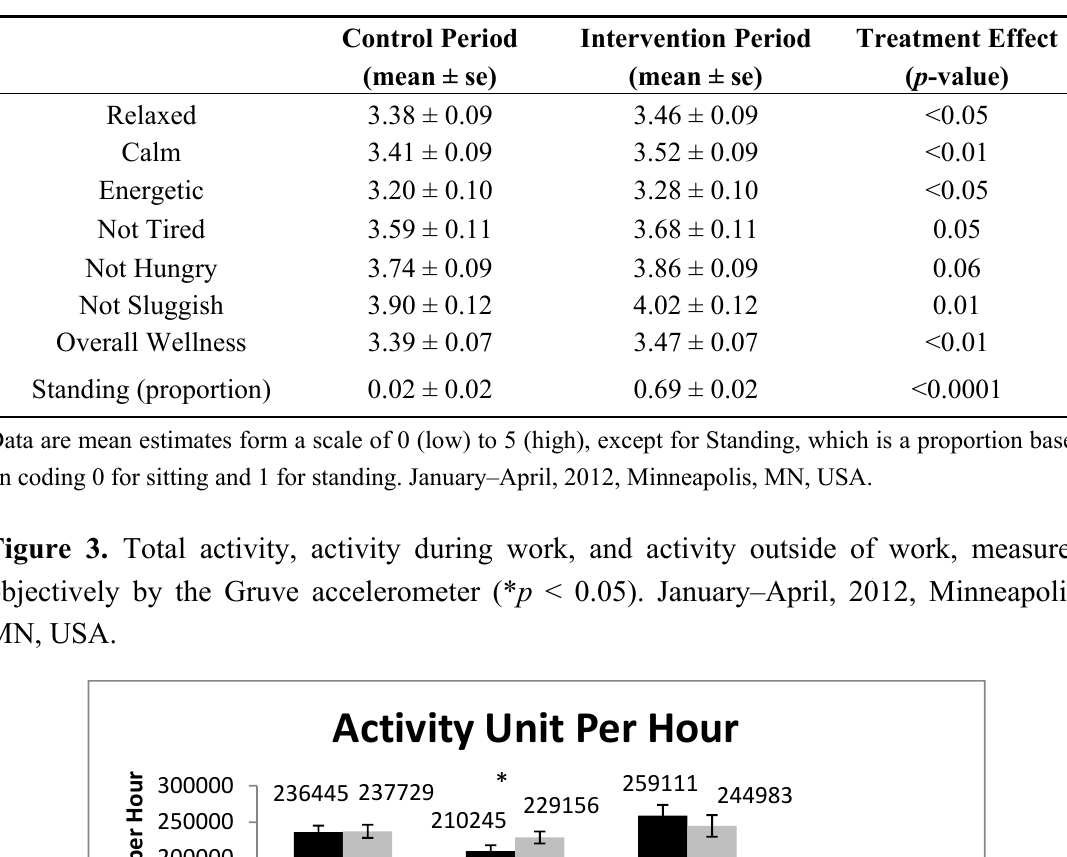
Table 1. Results of the Ecological Momentary Assessment